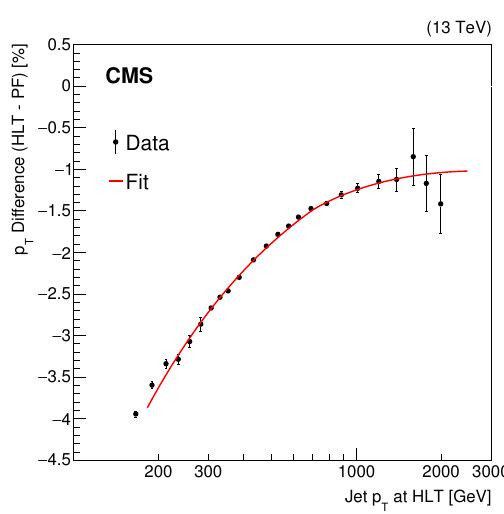
Figure 2 . The calibration of jets in the low-mass analysis. The percent di(cid:11)erence in data (points), between the p T of the wide jets reconstructed from Calo-jets at the HLT and the wide jets recon- structed from PF-jets, is (cid:12)t to a smooth parameterization (curve), as a function of the HLT p T . the p di(cid:11)erence, as a function of jet p , from the monitoring data set. The measured T T points are (cid:12)t with a parameterization and the resulting smooth curve is used to calibrate the wide jets in the low-mass